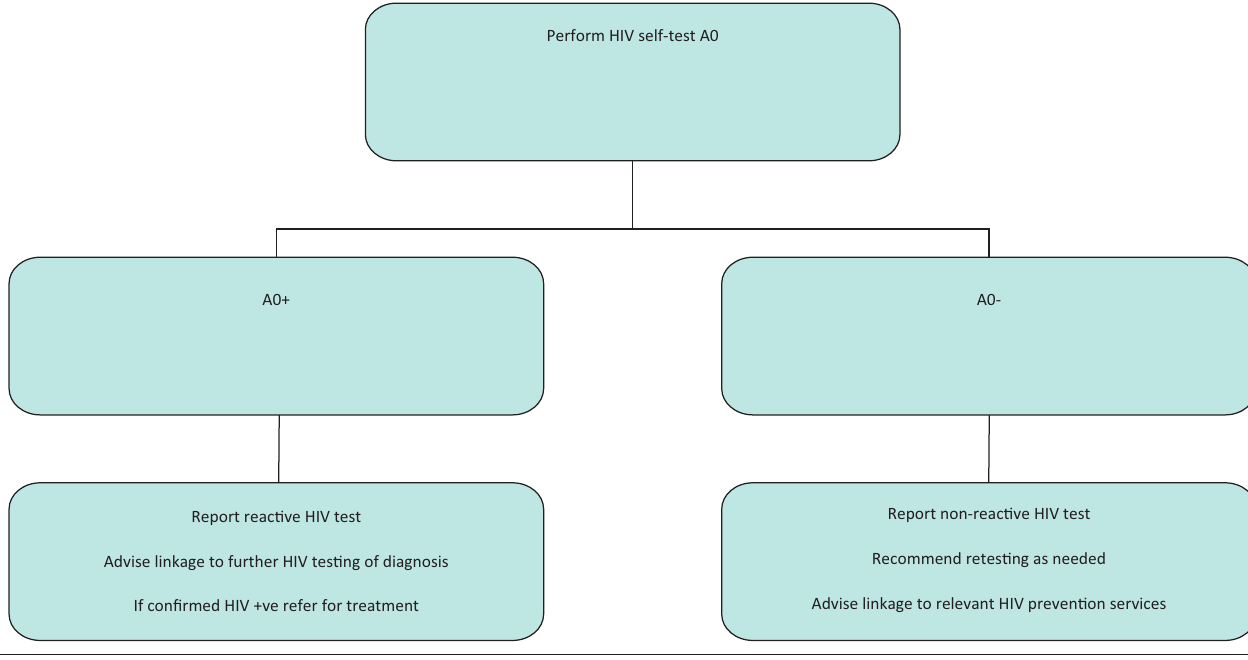
FIGURE 1: HIV self-testing